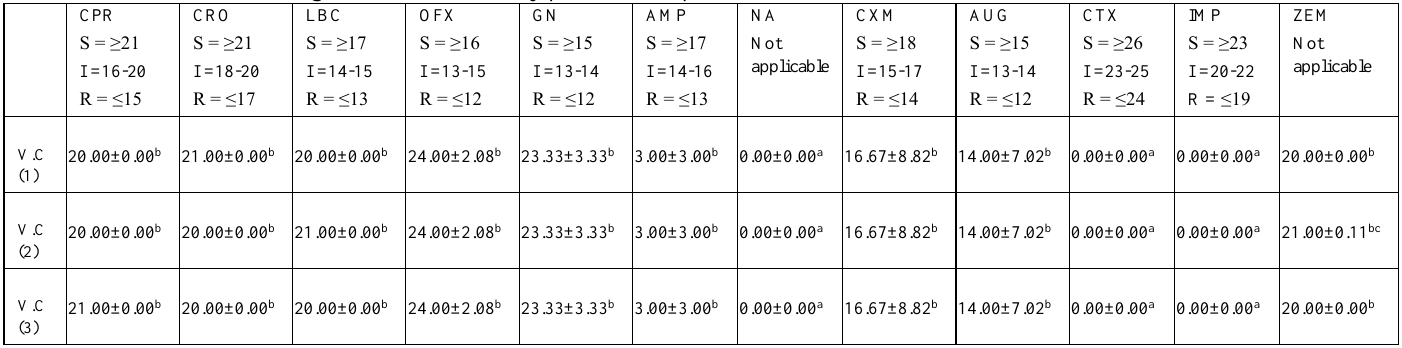
Table 4. Post curing antibiotics sensitivity pattern of ampicillin resistant Vibrio cholerae